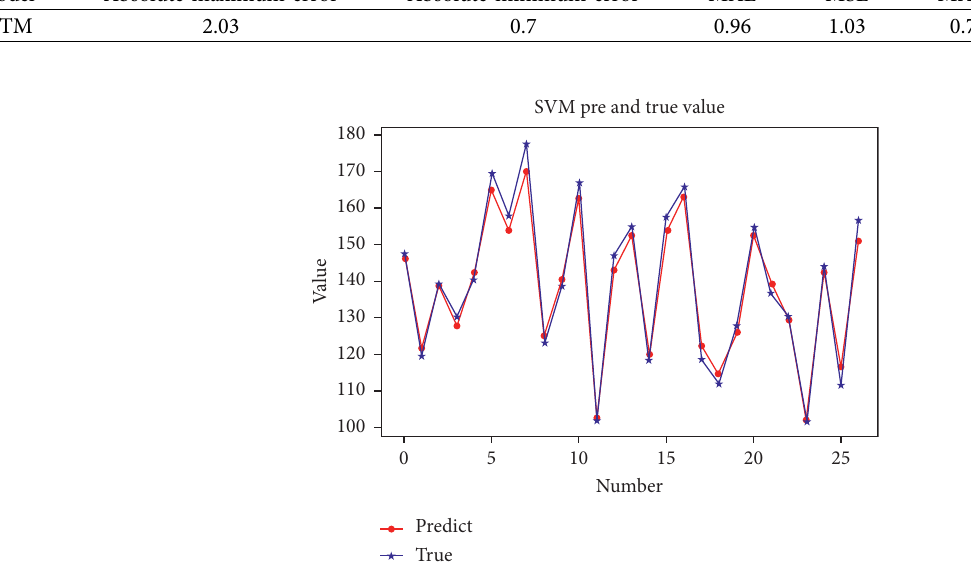
Figure 7: Prediction error trend of the SVM model. Table 4: Prediction error and accuracy results of the SVM